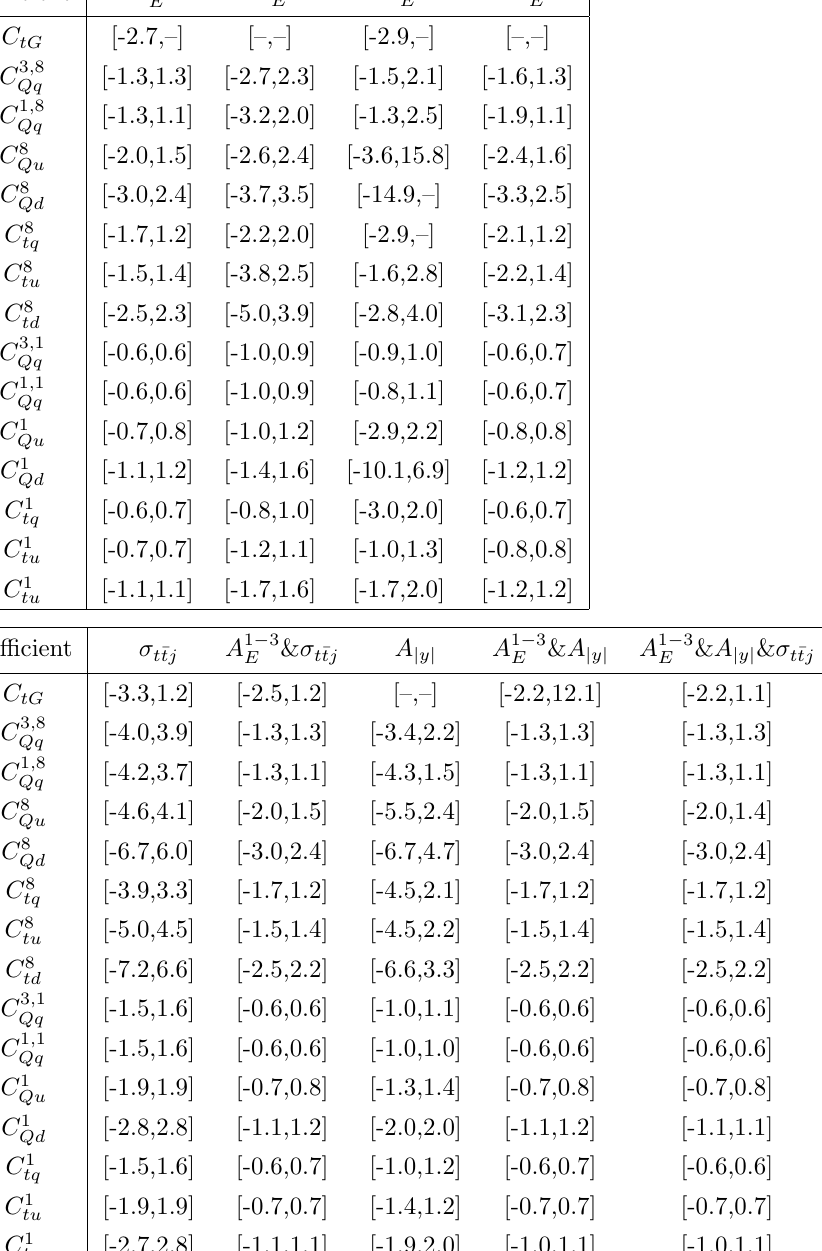
Table 5 . Expected 95% CL bounds on individual Wilson coe(cid:14)cients from (cid:12)ts to LHC measurements of the optimized energy asymmetry in three (cid:18) j bins A 1 cross section (cid:27) . All t (cid:22) tj observables are based on the boosted phase-space selection and a data t (cid:22) tj set of 139 fb (cid:0) 1 . We also show existing bounds from the rapidity asymmetry A measured during Run 2 [29], as well as combined (cid:12)ts to several observables. Empty spaces indicate that no limits could be found within C 2 [ (cid:0) 25 ; 25]. Bounds on C i are reported in units of TeV (cid:0) 2 .